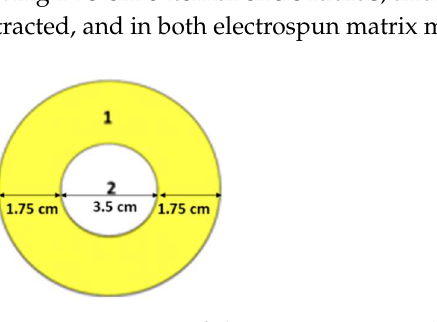
Figure 2. Representation of the two cut concentric portions of electrospun matrices: 1) crown, 2)